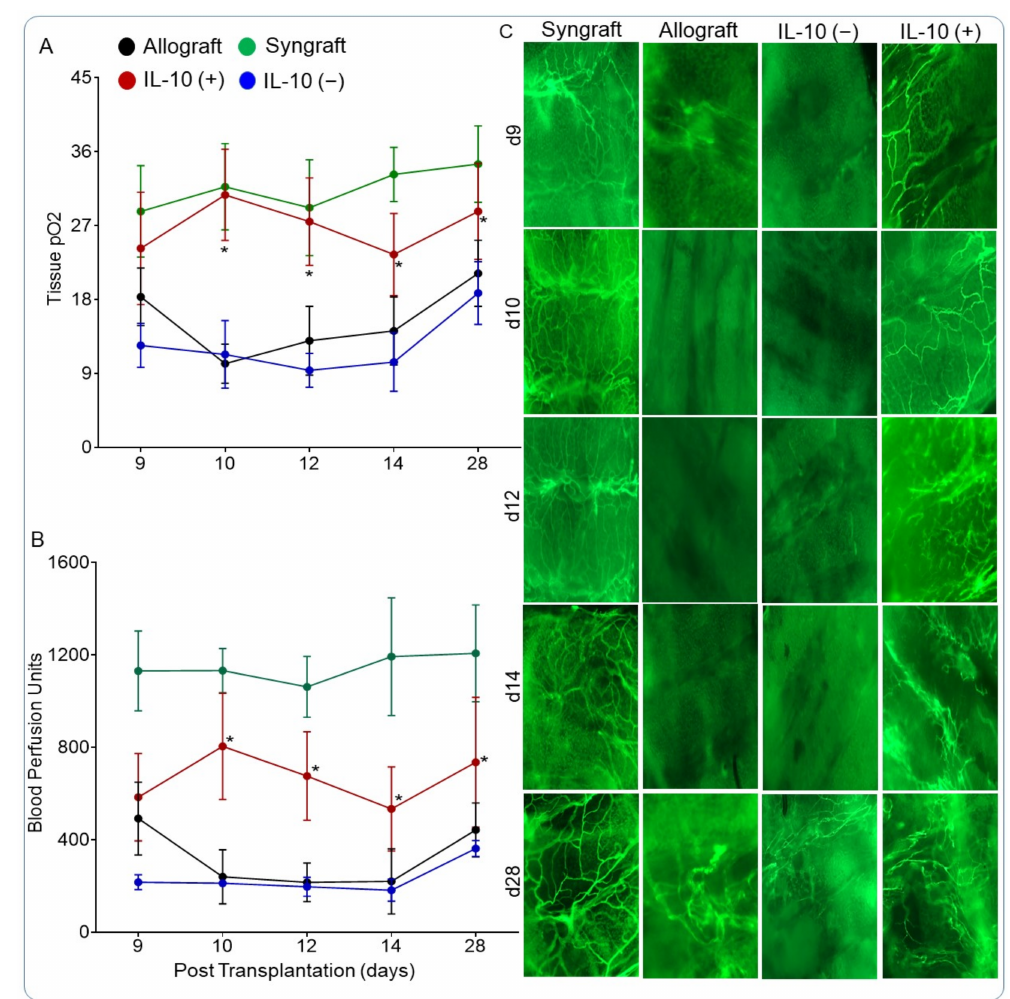
Figure 4. IL-10 is sufficient to restore graft oxygenation and microvascular blood flow. ( A ) Tissue pO 2 (mean ± SE, mmHg) and ( B ) Blood perfusion units (mean ± SE, units) were plotted over different time points (d9–d28). ( C ) Lectin binding assay in control and IL-10-treated allografts at d9, d10, d12, d14, and d28 post-transplantation. Original magnification, × 20. Data are presented as means with SE of 16 transplants/time point/experiment. * p <